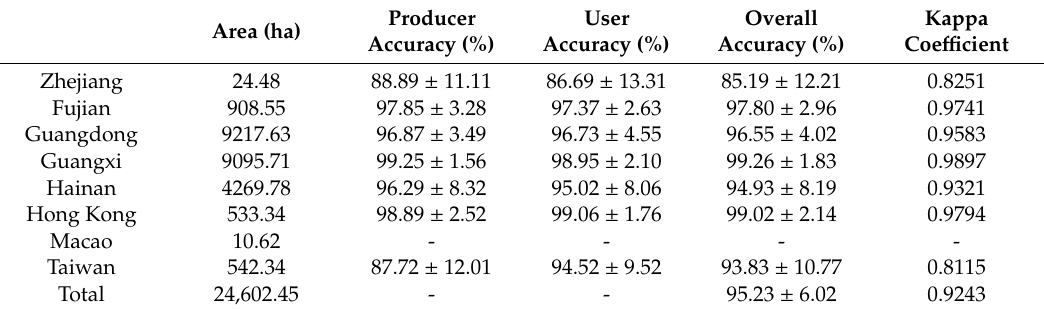
Figure 5. Spatial distribution of China’s mangroves in 2018 and zoom views of three natural mangrove reserves: ( a ) Guangxi Beilun Estuary National Nature Reserve; ( b ) Zhanjiang Mangrove National Nature Reserve; and ( c ) Zhejiang Ximen Island Marine Special Reserve. The background of ( a – c ) is PALSAR-2 mosaic in 2018 shown in R: G: B = HH: HV: HH-HV composite (Note: HH = Horizontal transmit and Horizontal receive). Table 2. Classification result and accuracy assessment for each province